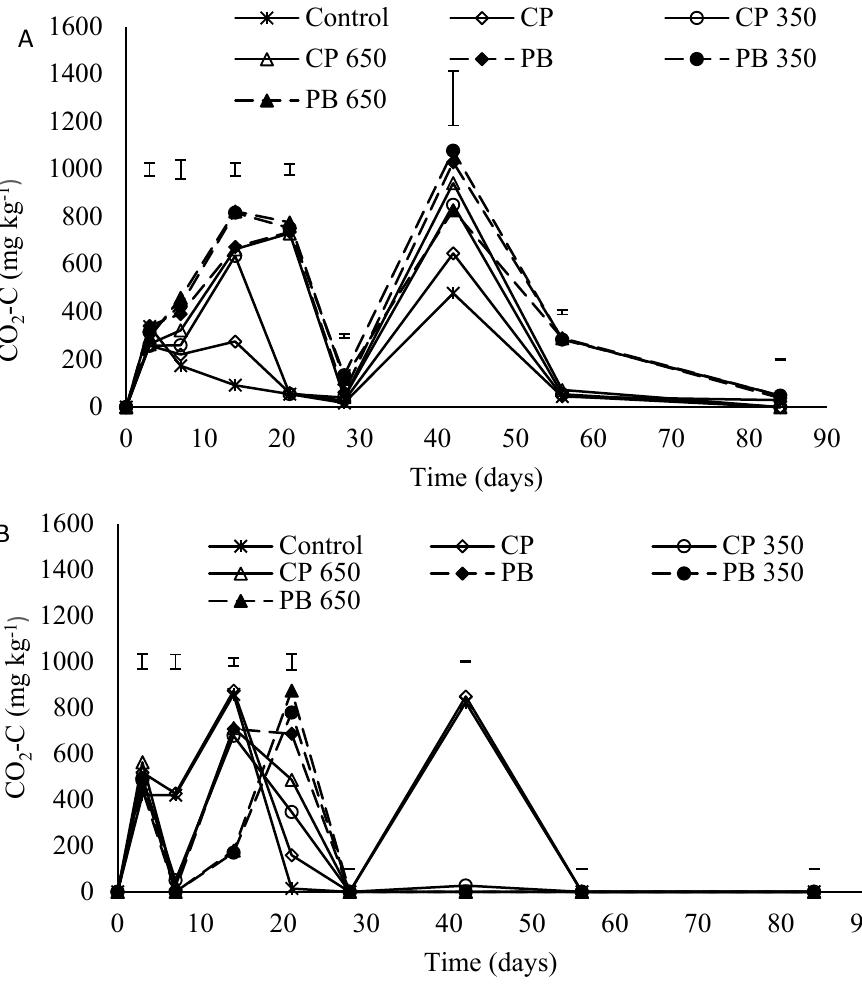
Figure 3. Carbon dioxide (CO 2 − C) emission during incubation of Luvisol ( A ) and Ferralsol ( B ) amended with biochar from cull potato (CP) and pine bark (PB) produced at varying pyrolysis temperatures. CP = cull potato; PB = pine bark; CP 350 = cull potato biochar at 350 ◦ C; CP 650 = cull potato biochar at 650 ◦ C; PB 350 = pine bark biochar at 350 ◦ C; PB 650 = pine bark biochar at 650 ◦ C. The vertical error indicates LSD ( p < 0.05).